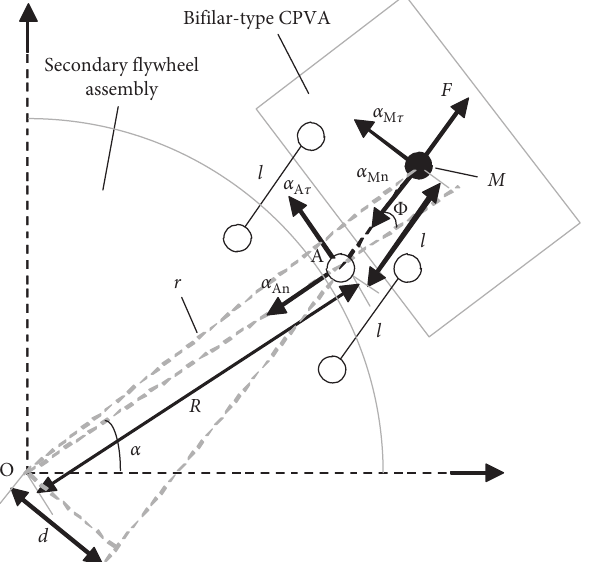
Figure 2: Simplified model of the bifilar CPVA. O : rotary center of the secondary flywheel; A : equivalent connection point of the CPVA; M : center of mass of CPVA; α : rotation angle of the secondary flywheel; ϕ : the swing angle of the CPVA relative to the secondary flywheel; R : distance between the equivalent connecting point of the CPVA and the rotary center of secondary flywheel; l: distance from the equivalent connecting point of the CPVA to its centroid; F : centrifugal force of the CPVA; d : force arm of centrifugal force; r : distance from the centroid of the CPVA to point; m : mass of the bifilar